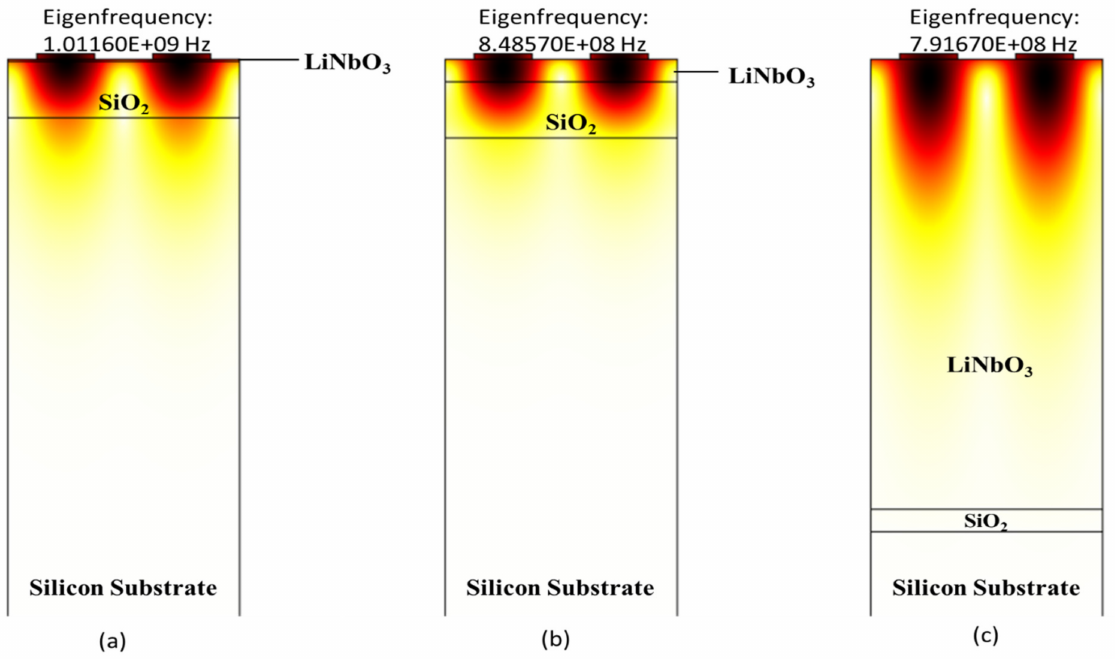
Figure 5. Zoom-in view of wave confinement and displacement profiles of structure B (LiNbO 3 /SiO 2 /Si) in Rayleigh mode with normalised thickness of LiNbO 3 ( a ) 0.01, ( b ) 0.1 and ( c )